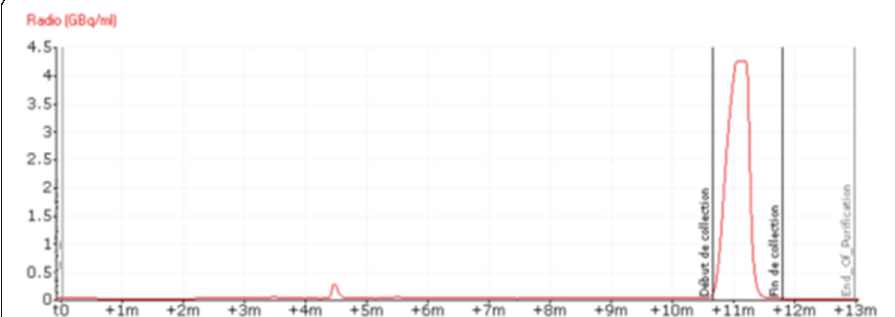
Fig. 4 Semi-preparative HPLC radiochromatogram of [ 18 F]LBT999 purification on AIO module: mobile phase and flow rate, ammonium acetate 0.1 M/acetonitrile: Agilent Zorbax EclipseXDB-C18 (9.4 × 250 mm, 5 μ m, CA, USA), 40/60 at 4 mL/min in presence of Na-Asc (0.5%) (RT = 10.5 –